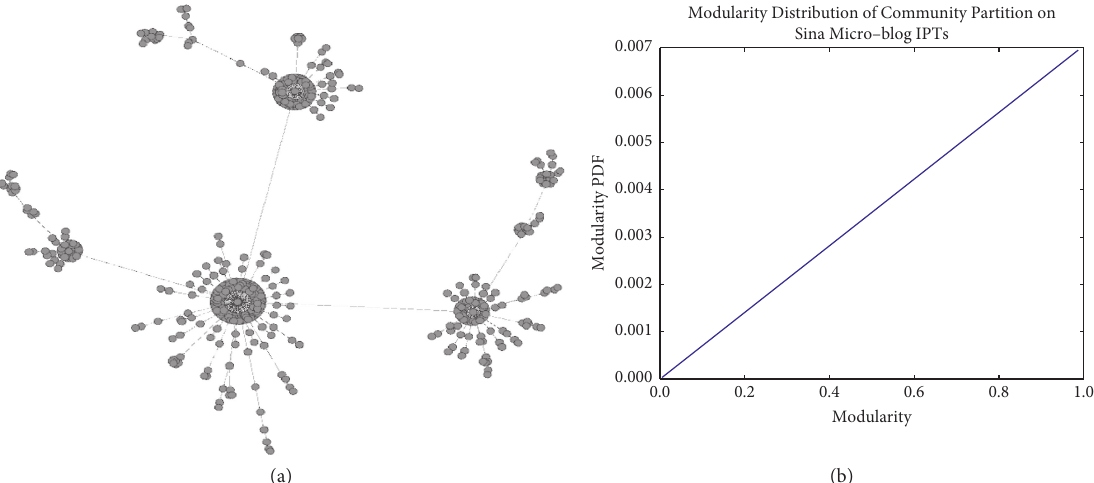
Figure 4: (a) An example of a community structure in one of the IPTs from the Sina Weibo; each cluster is a community structure, drawn by the Gephi; (b) the modularity distribution of community partition, which can be used to quantitatively measure the quality of network community